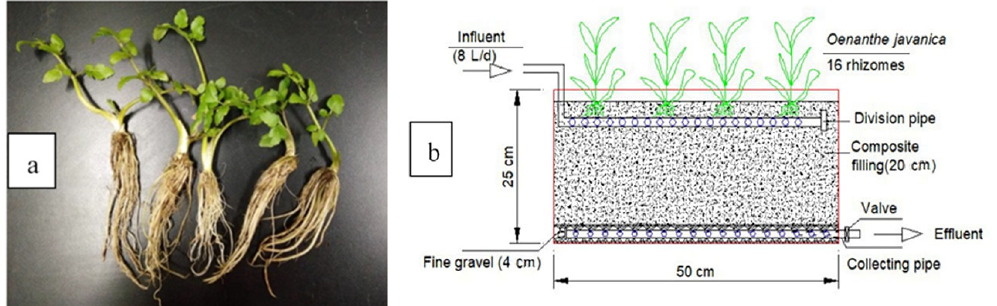
Figure 1. The general layout of the experimental facility ( a ); VSFCW treatment system ( b ).